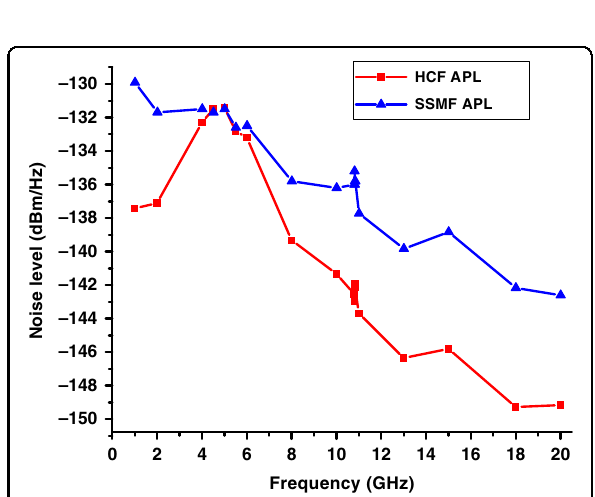
Fig. 13 The measured noise level of noise fi gure optimized SSMF (triangle) and HCF (square) APLs over the frequency range of 0 – 20